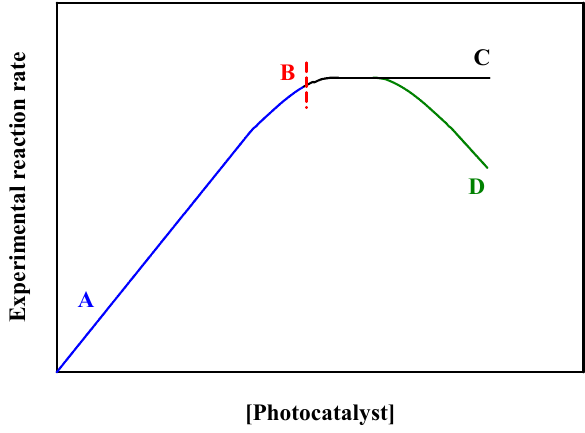
Figure 3. Experimental rate of the photocatalyzed reaction vs the concentration of photocatalyst.